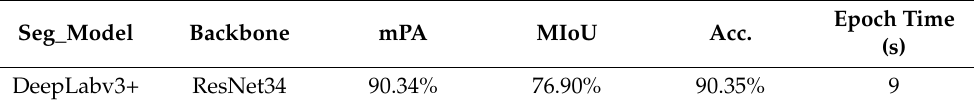
Figure 5. Diagram of segmentation effect of category A ( a ), B ( b ), C ( c ), D ( d ), and DS ( e ). Table 2. Model Training Result.